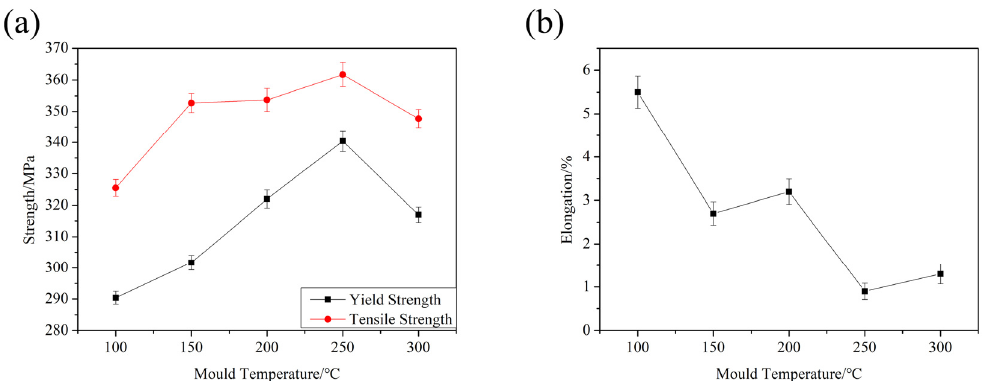
Figure 10. Strength and elongation of the samples at different mold pre-heating temperatures: ( a ) strength; ( b ) elongation.